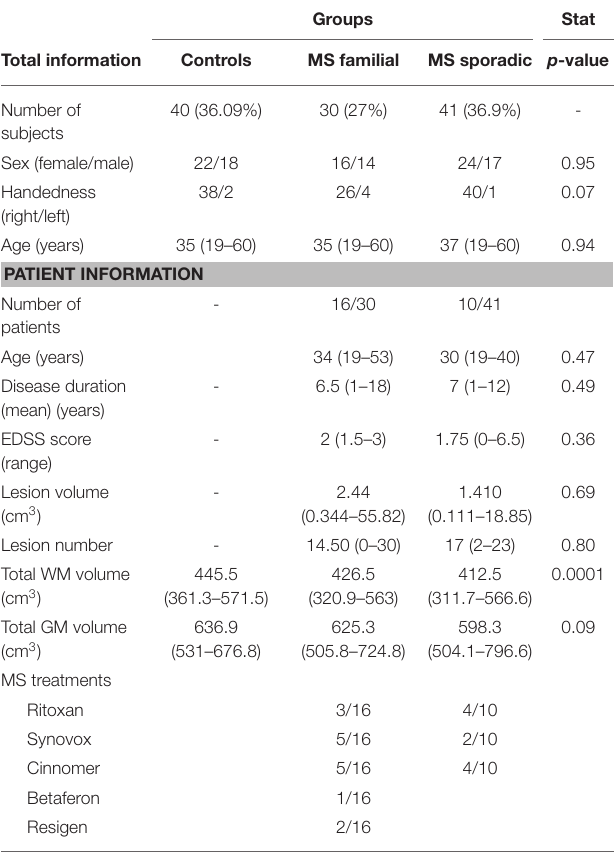
TABLE 1 | Demographic and clinical variables according to multiple sclerosis